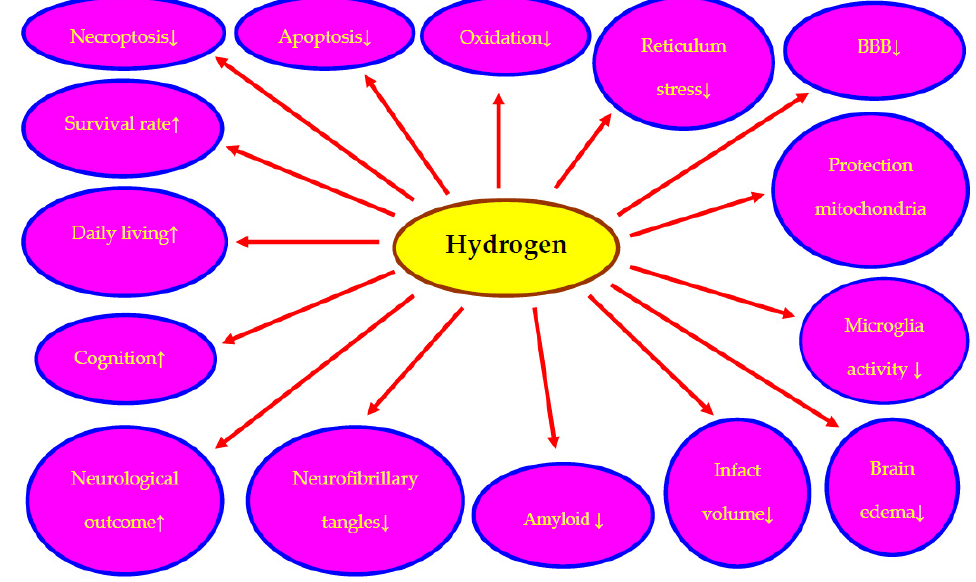
Figure 1. Neuroprotective mechanisms of molecular hydrogen on post-ischemic brain neurodegener- ation phenomena. BBB-blood-brain barrier. ↓ —reduction, ↑ —increase.